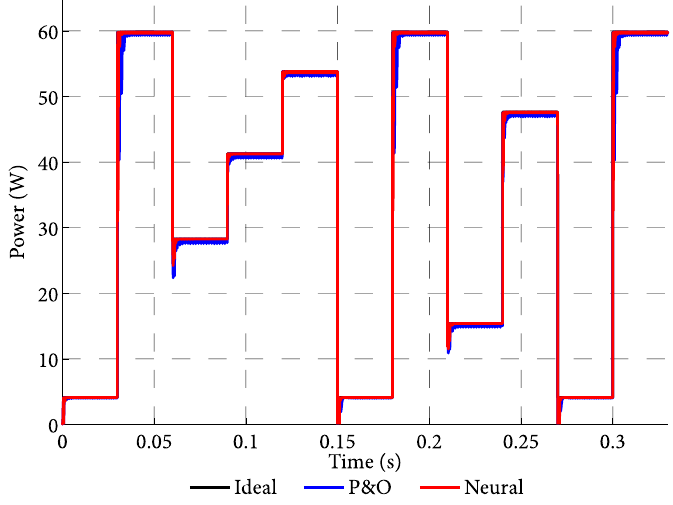
Figure 21. Output power of the PV module under variable irradiation.